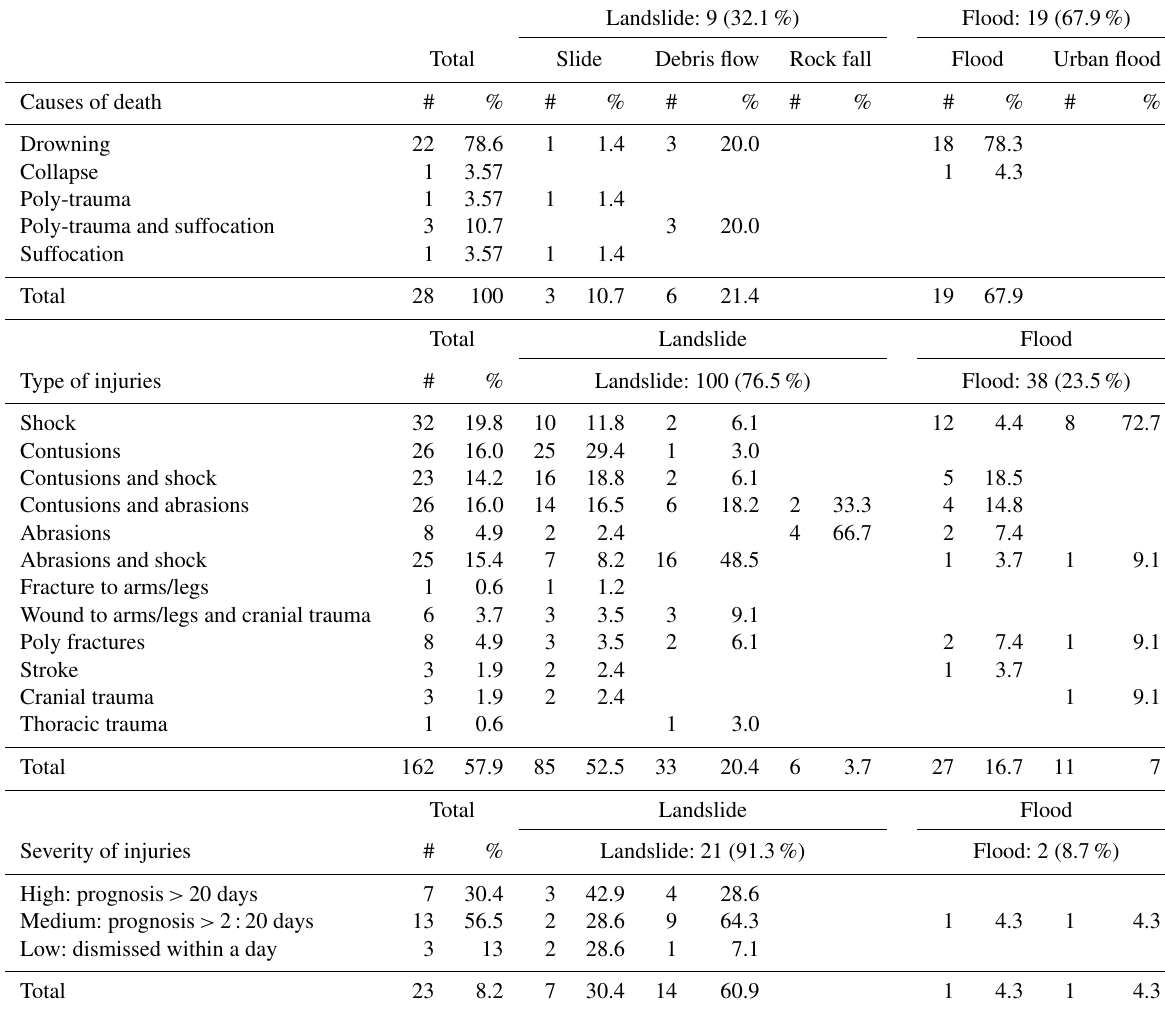
Table 4. Causes of death and types of injures for type of processes.